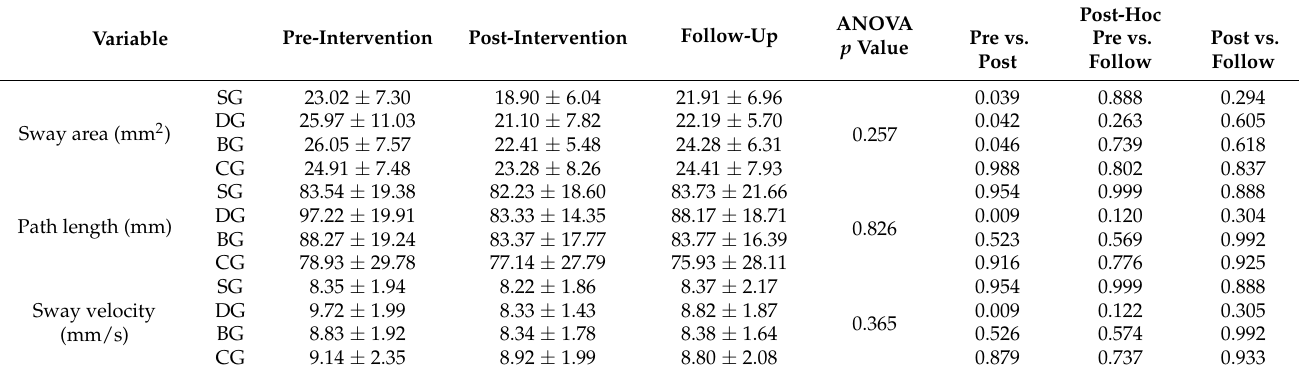
Table 3. Static balance ability in the eyes-closed